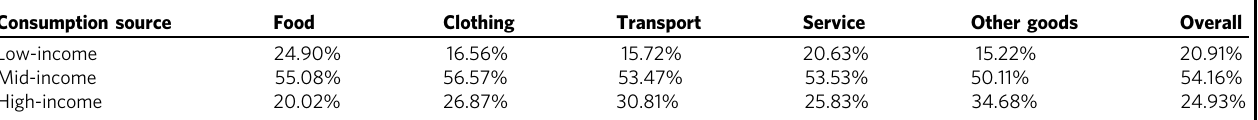
Table 2 Ratios of consumed commodities for household